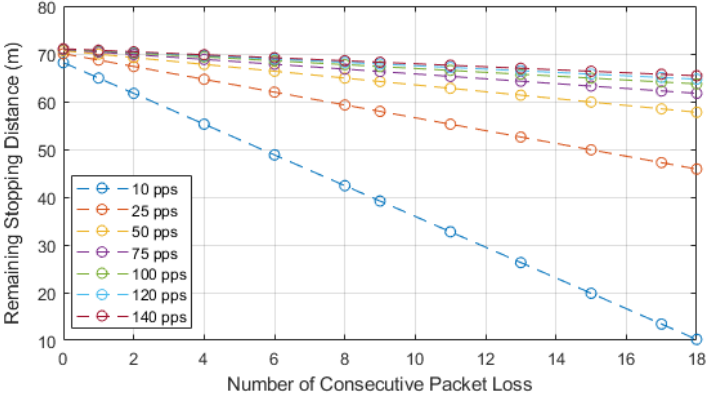
Figure 6. Seventy miles per hour (112.63 km/h) reduction in stopping